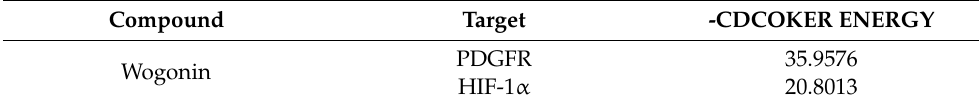
Table 1. Molecular docking analysis of wogonin at active sites.